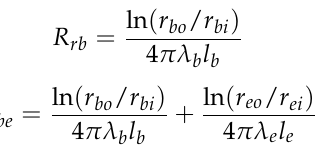
Figure 11. LPTN model of the internal air.